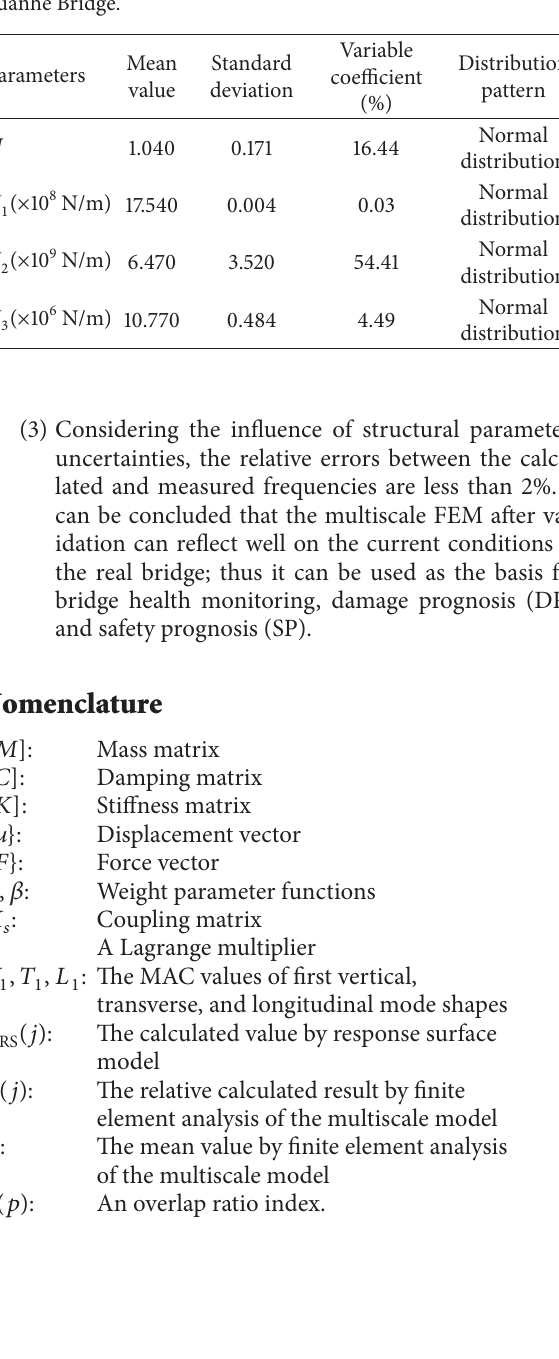
Table 10: Sample data of measured frequencies.